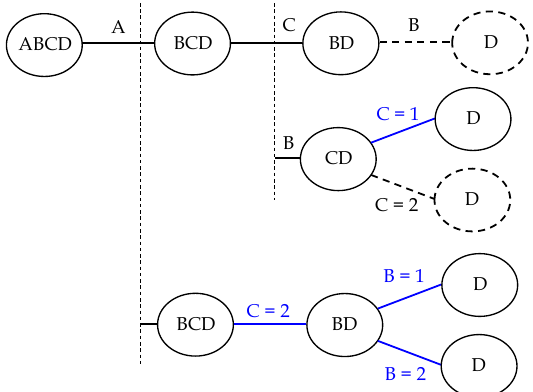
Figure A13. Tree graph for the analysis of the effect of factor D on the expected accuracy performance. Dashed nodes and arcs correspond to rejected conclusions due to multimodal population. Arcs in blue denote decisions on the value of factors based on forced interactions.